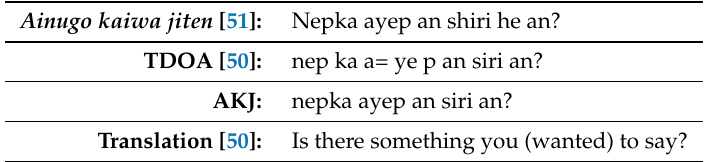
Table 3. Statistics of the samples used for evaluation and their modern transcription equivalents. Avg. Characters Data Segments (Excluding Spaces)